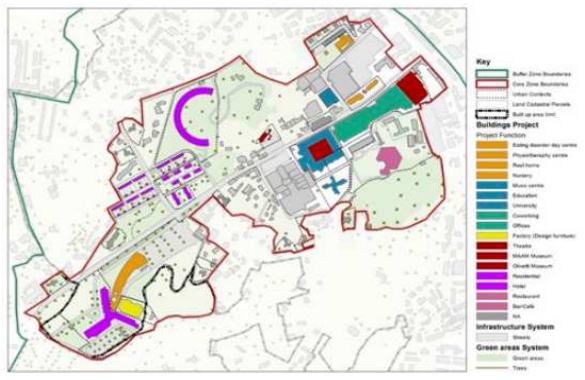
Figure 10. Ivrea, thematic map for the definition of new functions with energy retrofit and reusing (Barreca et al. 2017)